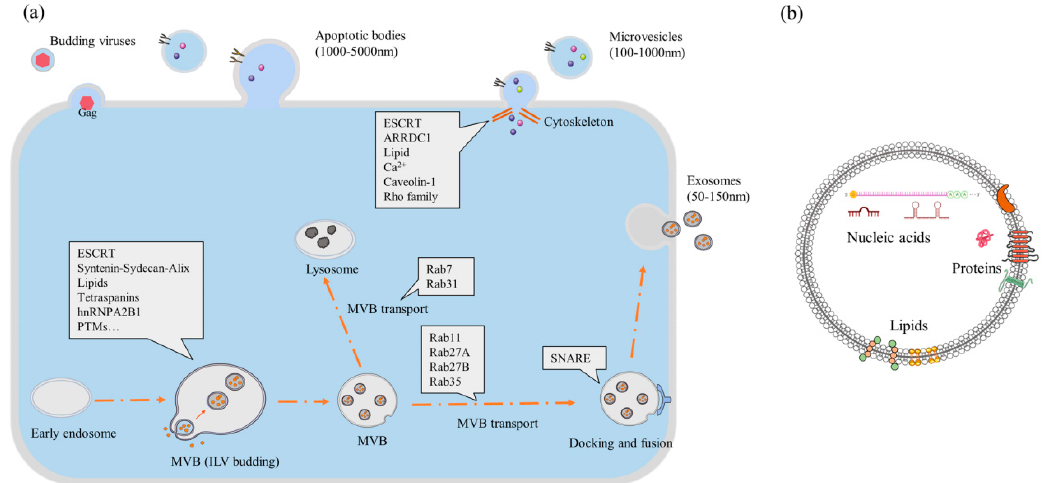
Figure 1. The biogenesis of the extracellular vesicle and its structure. ( a ) EVs can be divided into three subtypes: exosomes, microvesicles, and apoptotic bodies. ( b ) The extracellular vesicle is made up of lipid bilayers and enriched in proteins, nucleic acids, and lipids (The figure is cited from Jin Y, Ma L, Zhang W, Yang W, Feng Q, Wang H. Extracellular signals regulate the biogenesis of extracellular vesicles [34].).